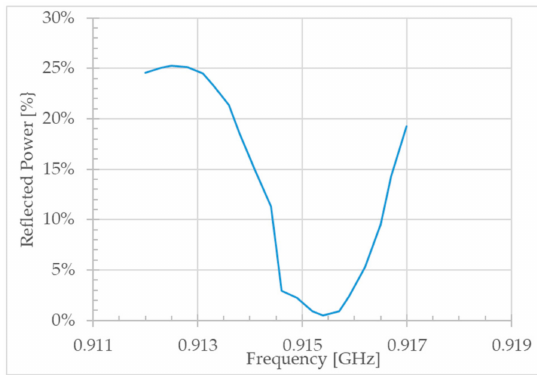
Figure 6. Dissipated power in water load as a function of frequencies centered around 915 MHz.